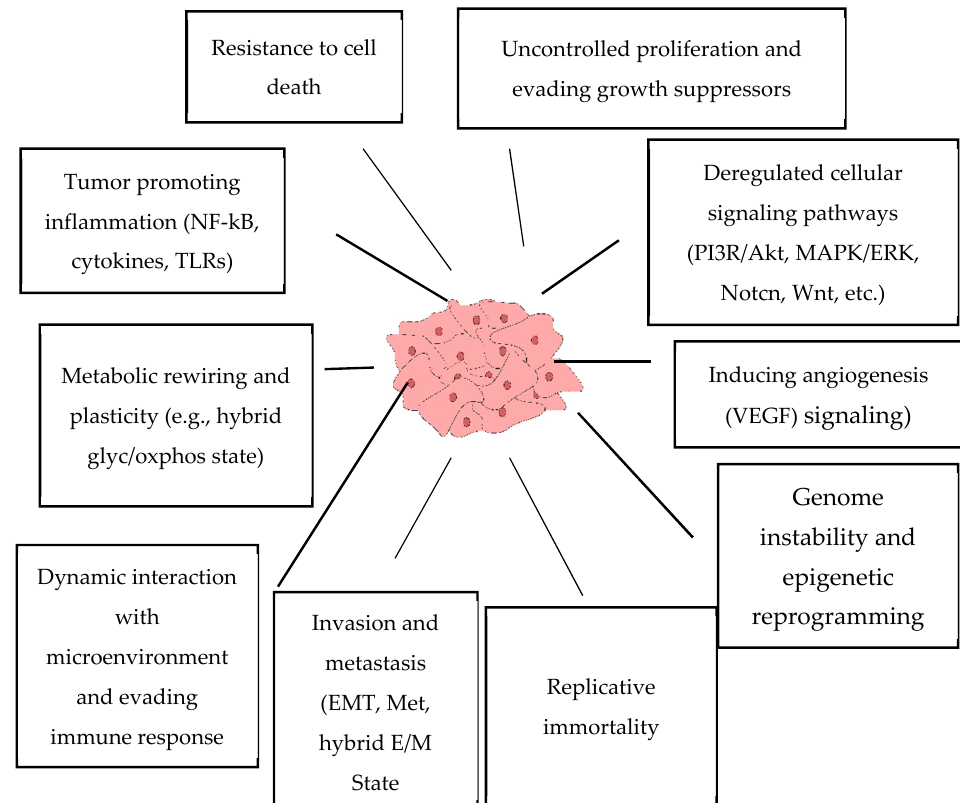
Figure 1. Main “hallmarks” of cancer.